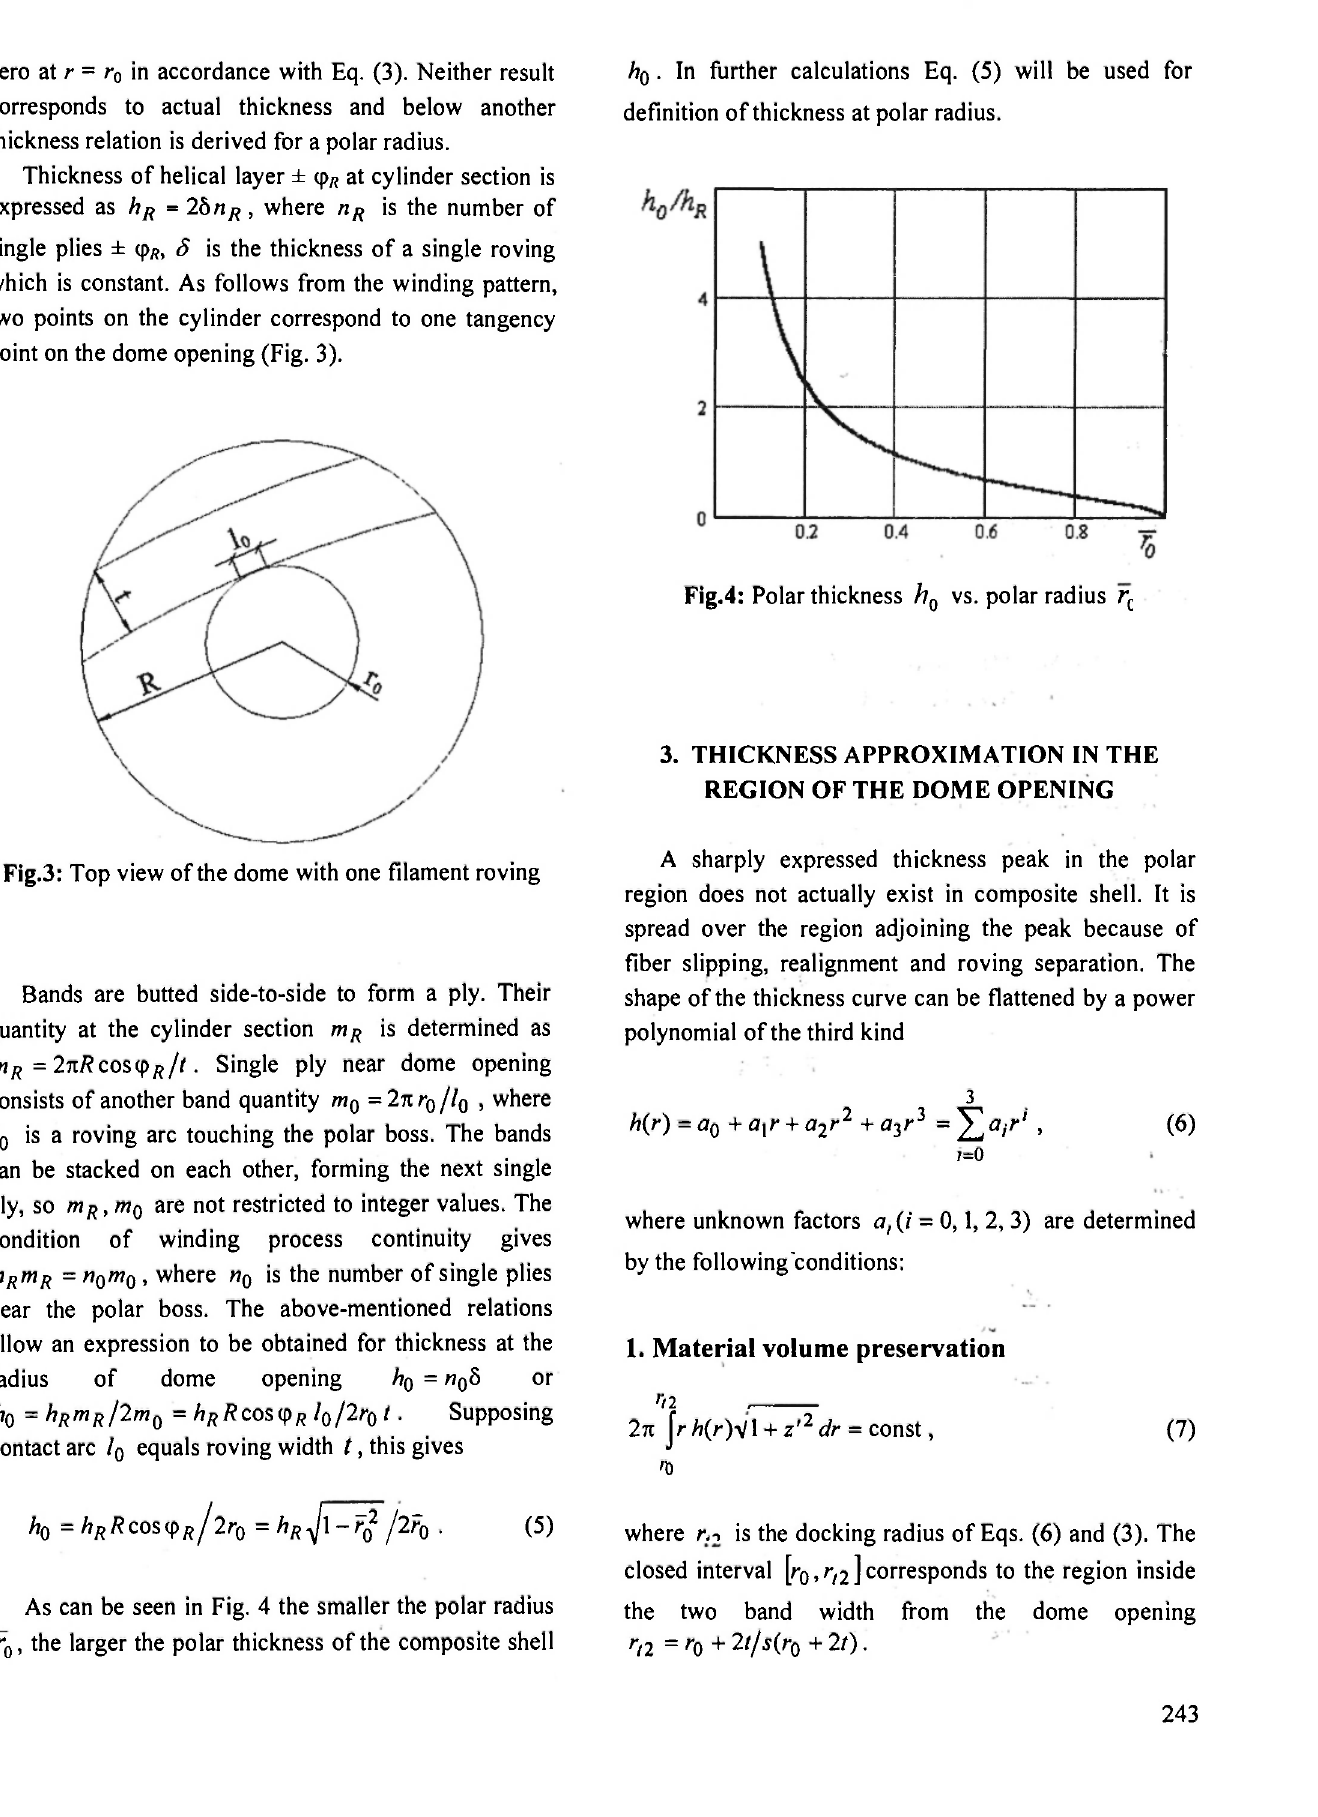
Fig.4: Polar thickness h 0 vs. polar radius r c